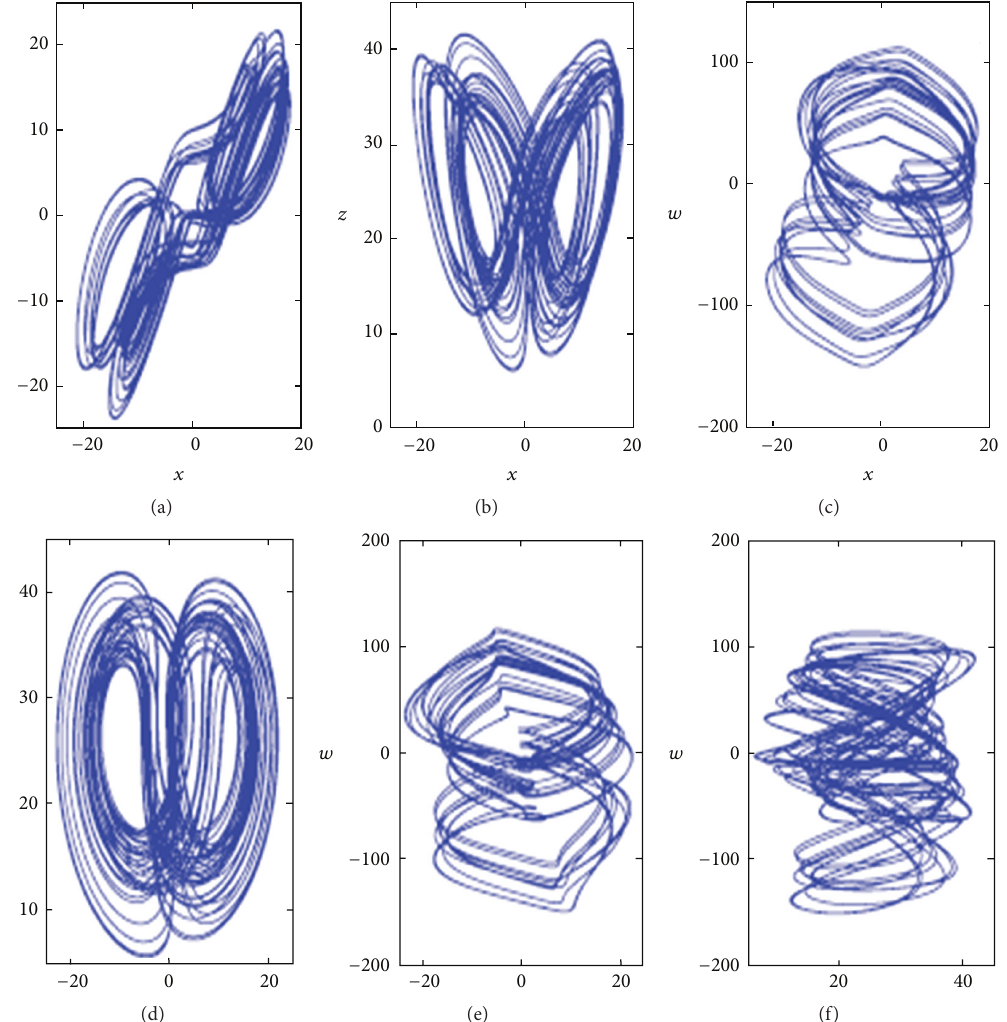
Figure 2: Chaotic attractor projections of fractional-order hyperchaotic Lorenz system when 𝑝 = 0.98 and (𝑎, 𝑏, 𝑐, 𝑟) = (10, 8/3, 28, −1) .